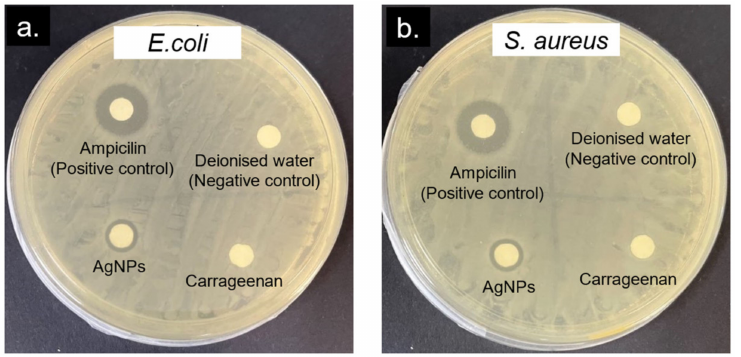
Figure 7. Representative agar plates of the disk diffusion assay showing the antibacterial activity of carrageenan (2.5 mM) and c-AgNPs (0.1 mg/mL) against ( a ) E. coli and ( b ) S. aureus . Ampicillin (0.1 mg/mL) and deionised water were used as the positive and negative controls,